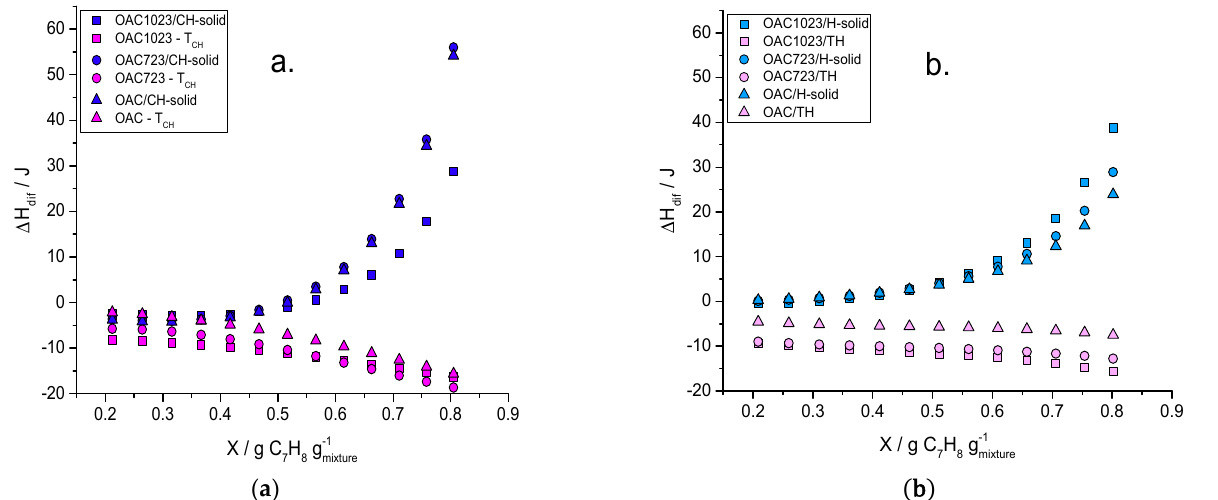
Figure 7. Differential enthalpies of toluene and solvent–solid component: cyclohexane–solid ( a ) and hexane–solid ( b ) in function of the mass fraction of C 7 H 8.